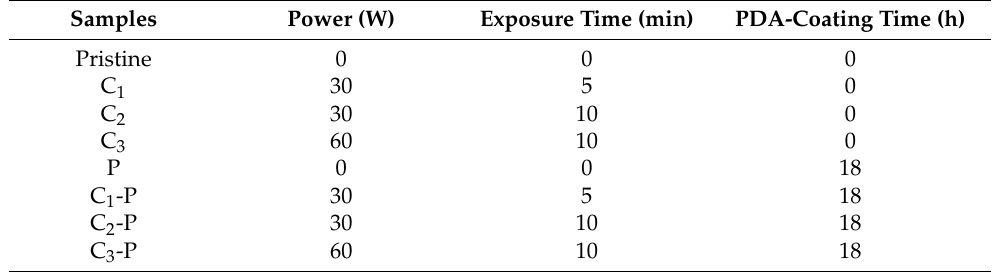
Table 1. Representative experimental parameters and corresponding